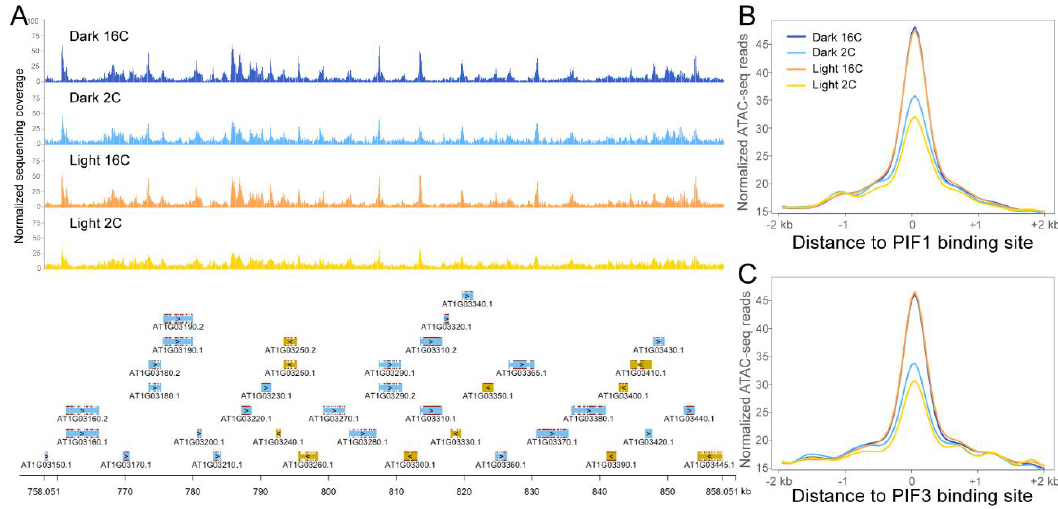
Figure 2. Chromatin accessibility patterns of 2C and 16C nuclei from dark and light treated hypocotyls. ( A ) Representative ATAC-seq peaks of different samples from a 100 kb genomic region of Chr1. In the panel below, genes indicated by blue are on the “Watson” strand and yellow ones are on the “Crick” strand. ATAC-seq read density is plotted with 50 bp windows. Normalized ATAC-seq signals around PIF1 ( B ) and PIF3 ( C ) transcription factor (TF) binding sites.